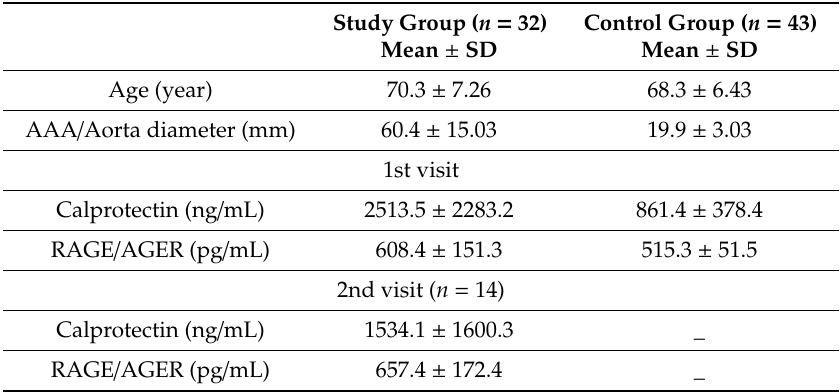
Table 2. Results obtained in the control and study